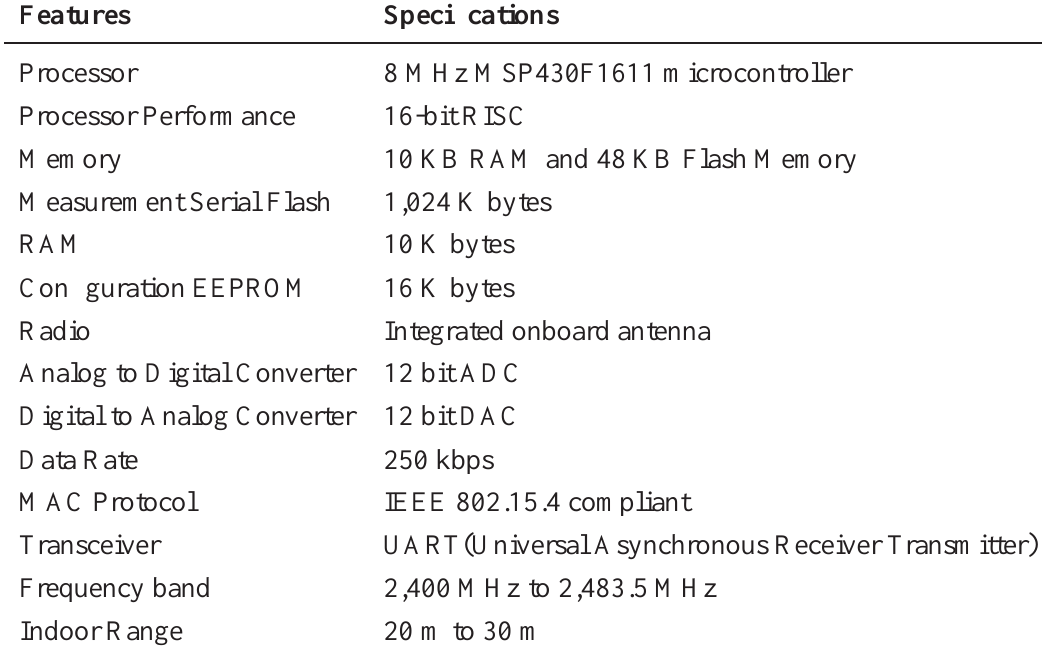
Table 1. Prototype of generic sensor nodes (TelosB Mote-TPR2420).